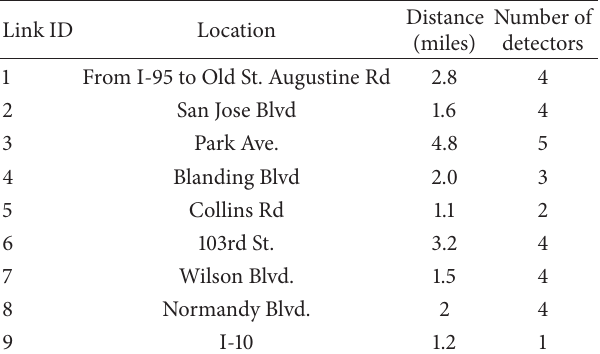
Table 1: Summary of